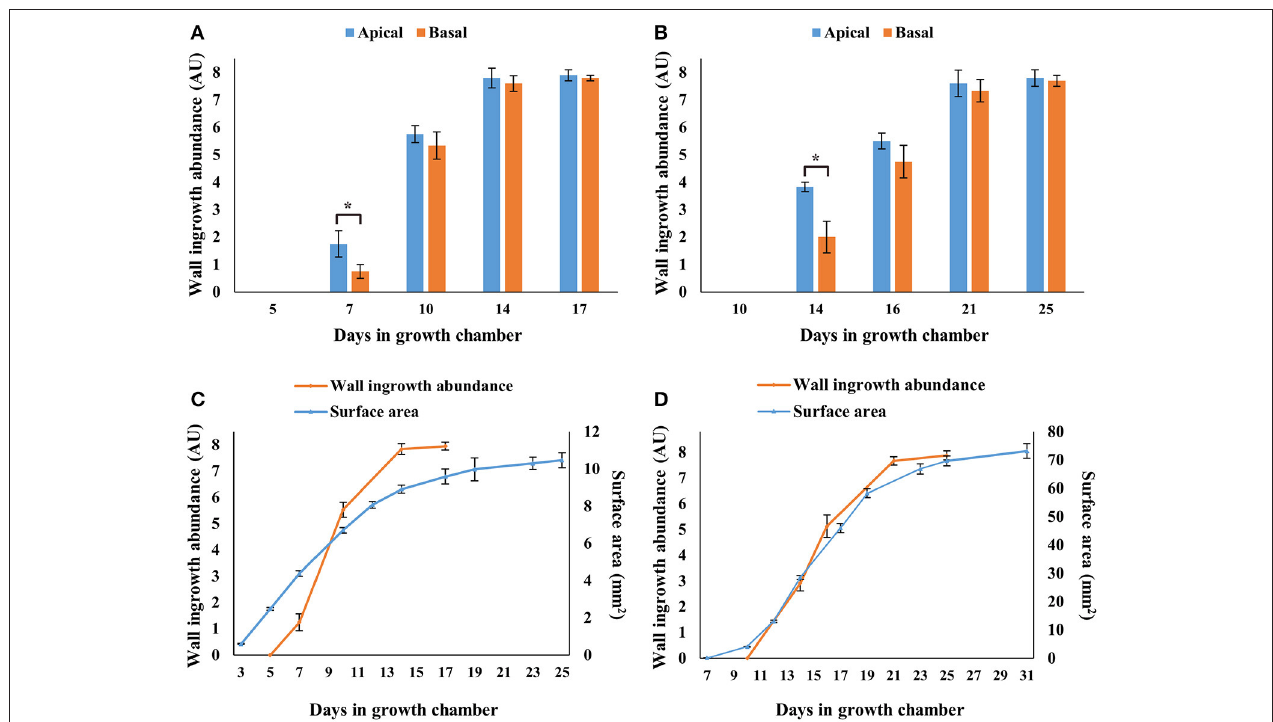
FIGURE 3 | Semi-quantitative analysis of wall ingrowth deposition in cotyledons and first leaves at selected developmental stages, and relationship with surface area expansion across Arabidopsis rosette development. Wall ingrowth deposition was not detected in cotyledons (A,C) or Leaf 1 and 2 (B,D) at days 5 and 10, respectively, but increased dramatically thereafter and was maximally abundant by day 14 in cotyledons and day 21 in Leaf 1 and 2. Differences in wall ingrowth abundance in PP TCs between apical (blue bars) and basal (orange bars) regions of the organs was only statistically different in cotyledons at day 7 and leaves at day 14, where both showed ∼ 50% reduction in the basal half compared to the apical half. Orange lines in (C,D) represent average scores of wall ingrowth abundance in PP TCs combined from apical and basal regions of cotyledons (A) and leaves (B) , respectively. Blue lines in (C,D) represent cotyledon and Leaf 1 and 2 surface areas, respectively, determined from images imported into ImageJ . Data shows mean ± SE of scores for wall ingrowth deposition in arbitrary units (see Nguyen et al., 2017), and for surface area in mm 2 . * P < 0.05, n > 3, student’s t -test.